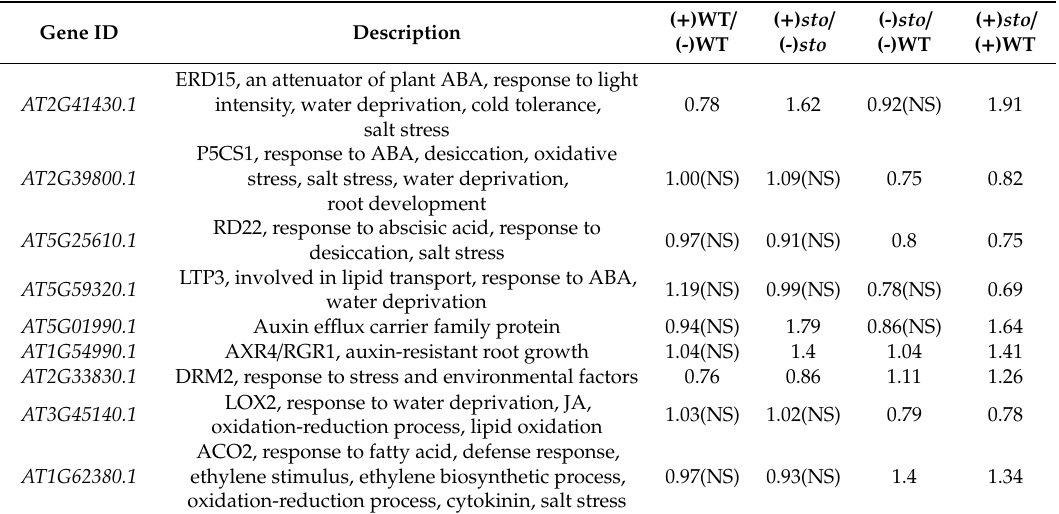
Table 5. Fold changes of hormone-related